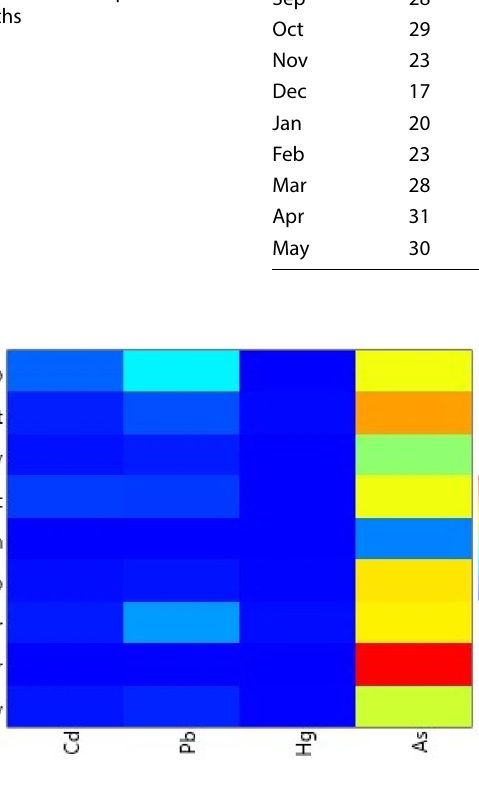
Table 2 In situ water quality variables recorded in different months from sampling location and in respective months